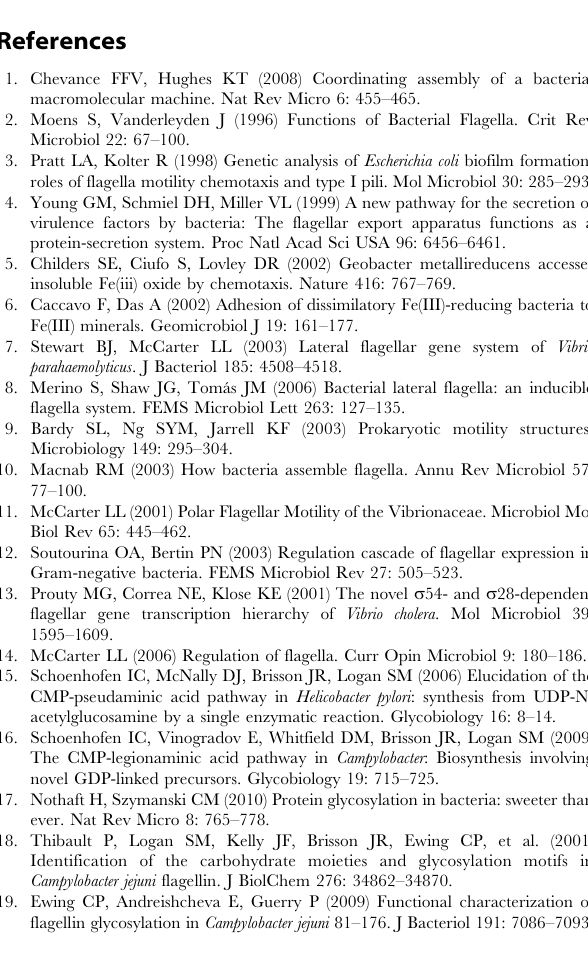
Table S1 s 28 -dependent genes in Shewanella